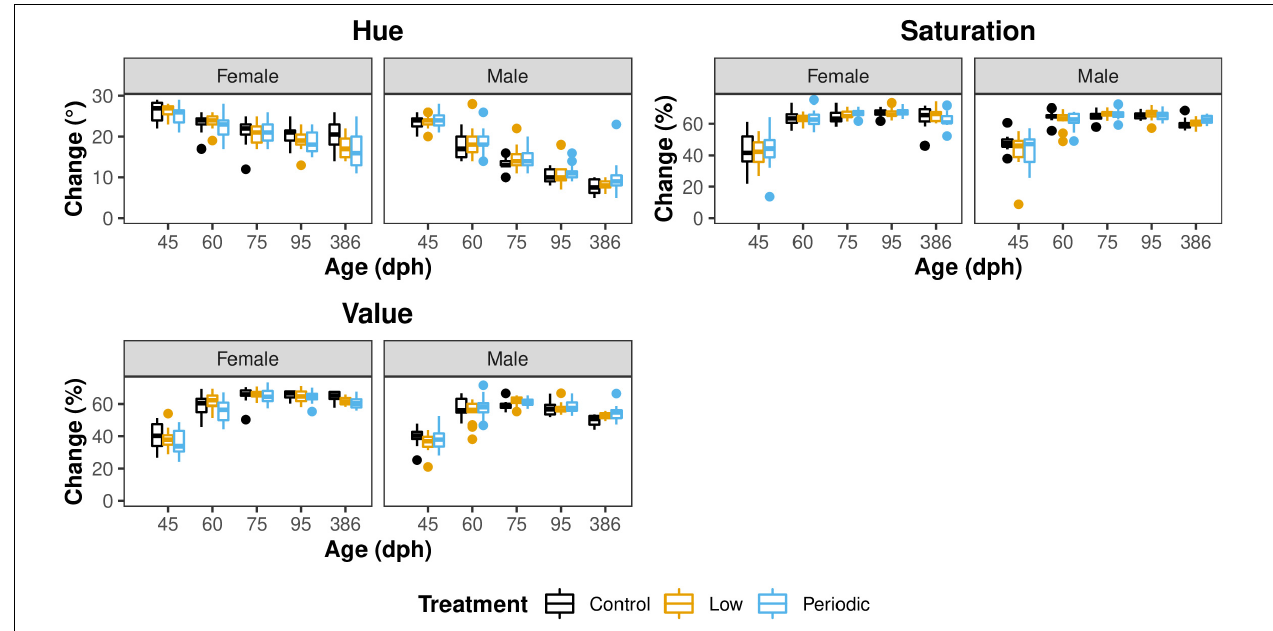
FIGURE 4 | Male and female hue decreases over time, and saturation and value plateau on 60 and 75 dph, respectively. Females are shown in the left panel, and males are shown in the right panel. Control, Low, and Periodic treatments are shown in black, yellow, and blue, respectively. The changes in hue, saturation, and value are measured on the y-axis, measured in degrees and percentage, respectively. Age is indicated on the x-axis, including 45, 60, 75, 95, and 386 dph,